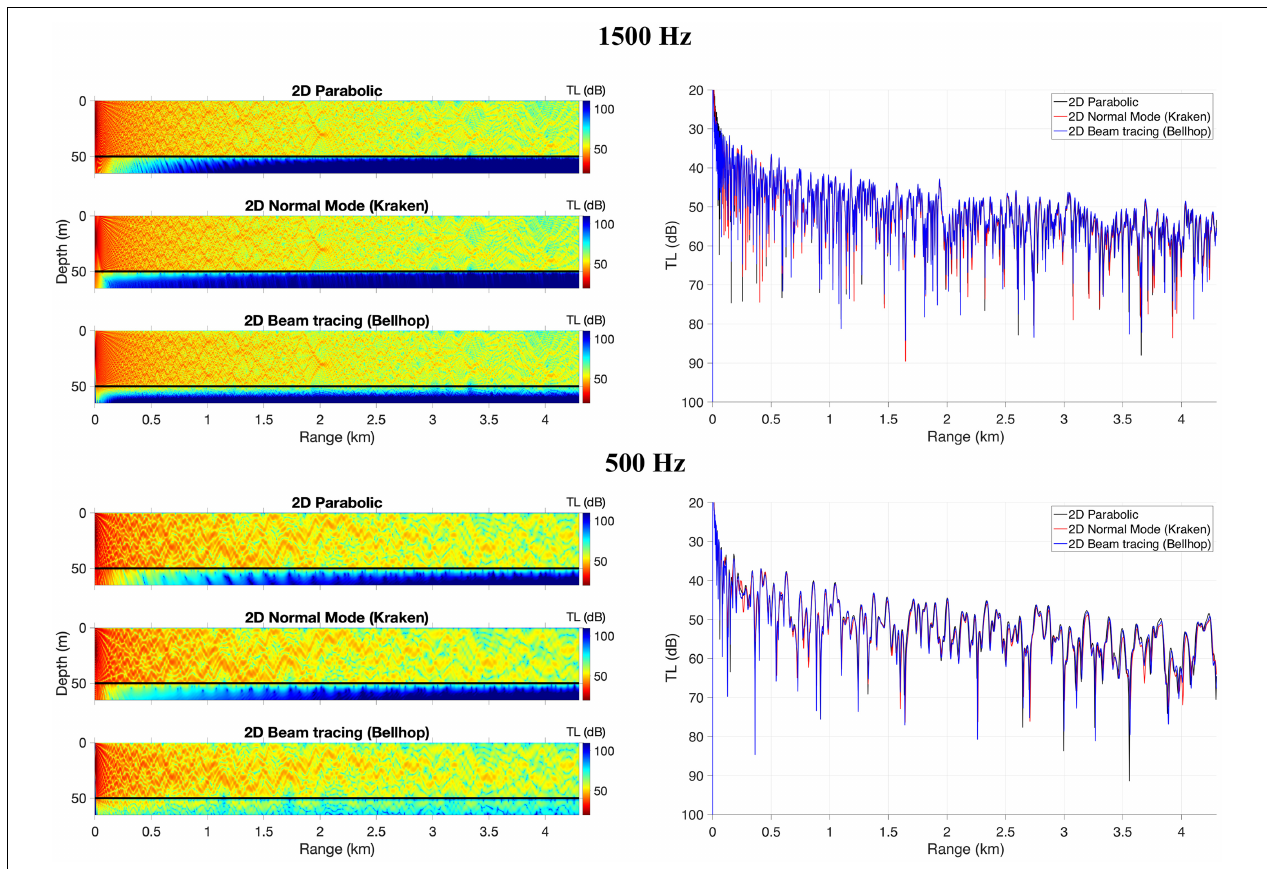
FIGURE 2 | Transmission loss for a 1500 Hz (top panel) and 500 Hz (bottom panel) sound source for an isovelocity ( c 0 = 1500m / s) waveguide with a flat bottom. Plots on the right present TL over the range at 20 m water depth. Results are presented for 2D parabolic, 2D normal mode (Kraken, mode coupling), and 2D beam tracing